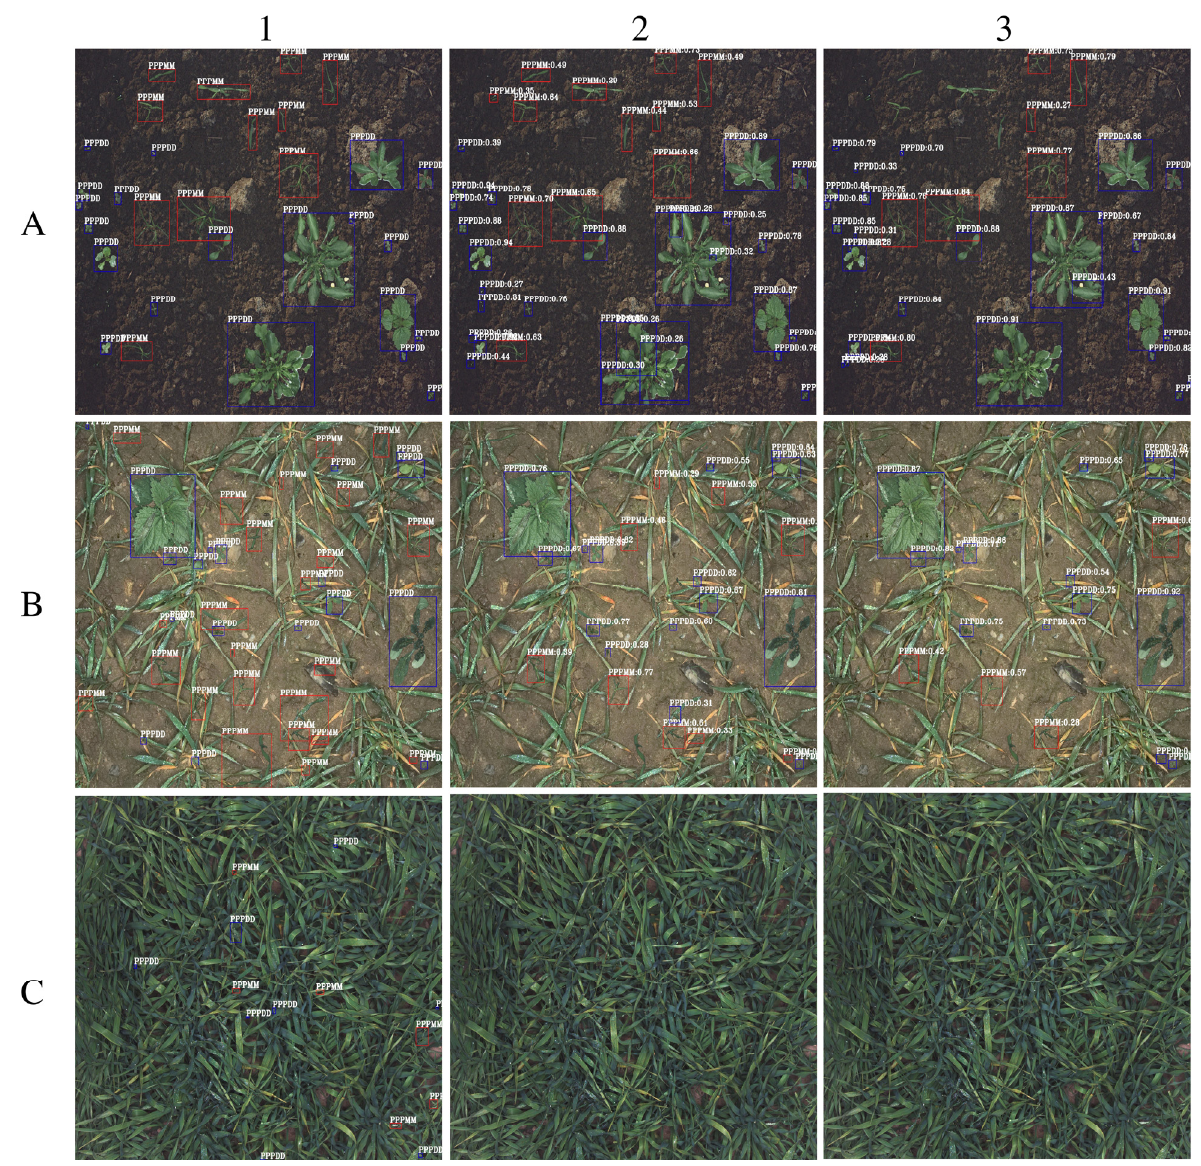
Figure 12. The monocot/dicot prediction by EfficientDet and YOLOv5 in synthetic images: ( A1 ) The label in the dark soil image; ( A2 ) The EfficientDet prediction; ( A3 ) The YOLOv5 prediction; ( B1 ) The label in the light soil image; ( B2 ) The EfficientDet prediction; ( B3 ) The YOLOv5 prediction; ( C1 ) The label in the dense image; ( C2 ) The EfficientDet prediction; ( C3 ) The YOLOv5 prediction. In this Figure, various crops and weeds occlusions are illustrated; red and blue bounding boxes represent monocot and dicot classes, respectively.